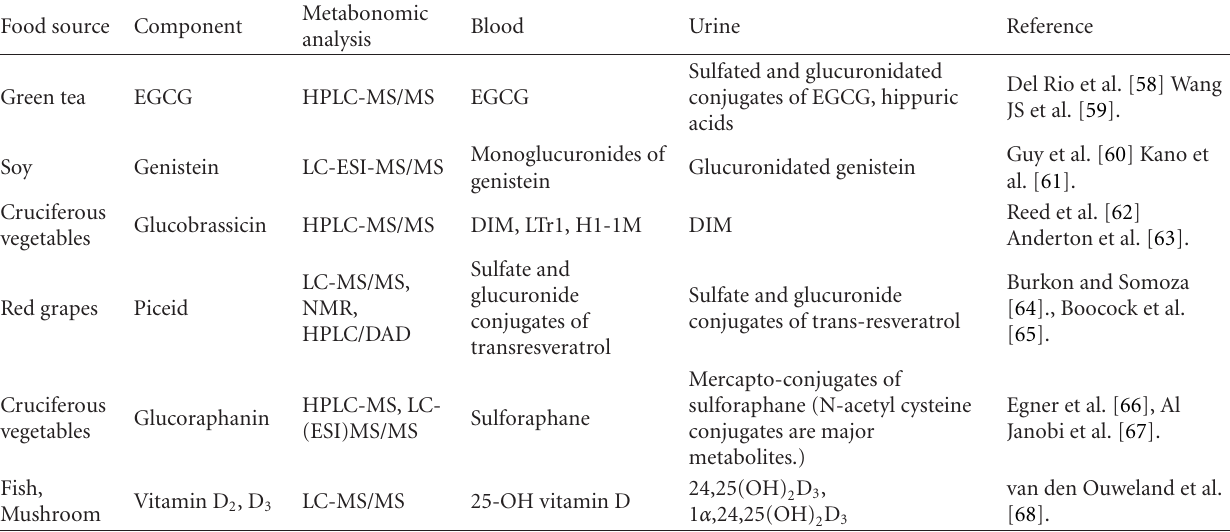
Table 2: Metabonomic profiles of metabolites from selected bioactive food components in human blood and urine. Food source